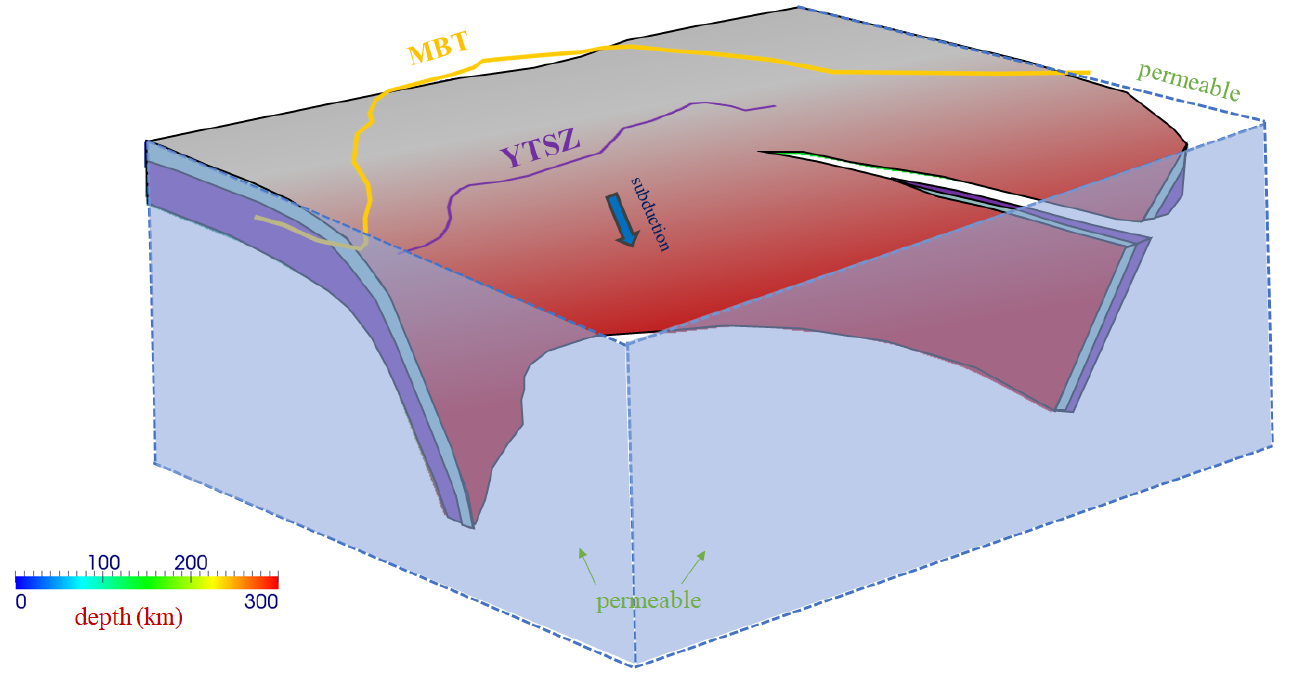
Figure 2. Conceptual figure of model domain and the slab geometry (splitting from west to east). The bottom and perpendicular planes are prescribed as adiabatic and permeable, and the top surface is set to be permeable. Detailed model settings are available in the Supplemental Information.